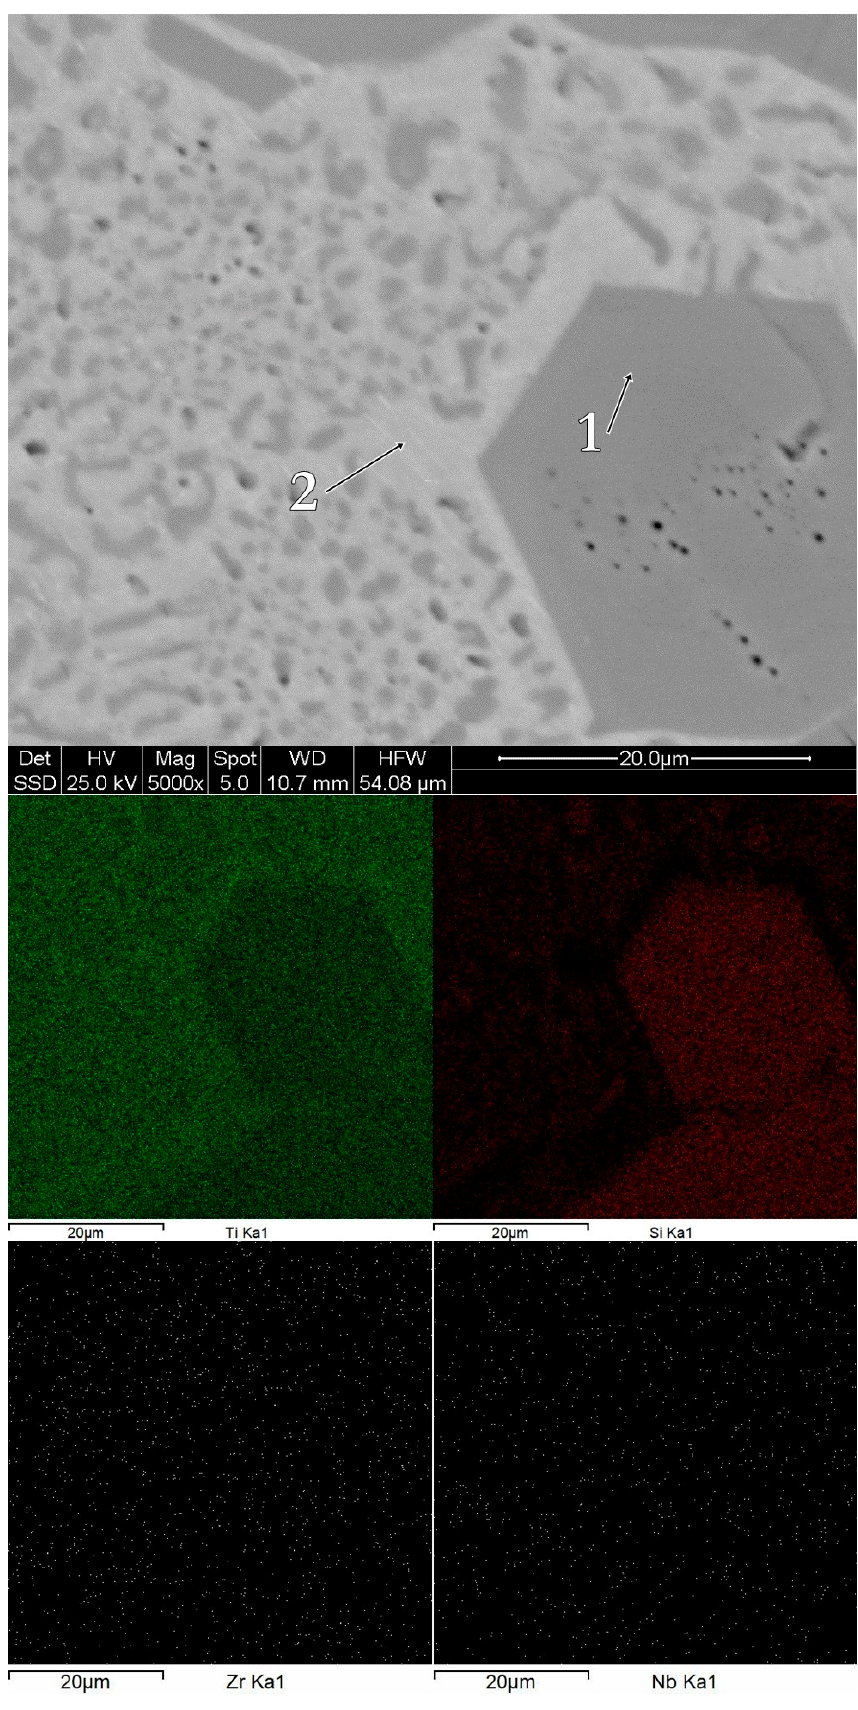
Figure 7. Surface morphology and chemical mapping for the bulk Ti 56 Zr 10 Si 15 Nb 19 alloy.